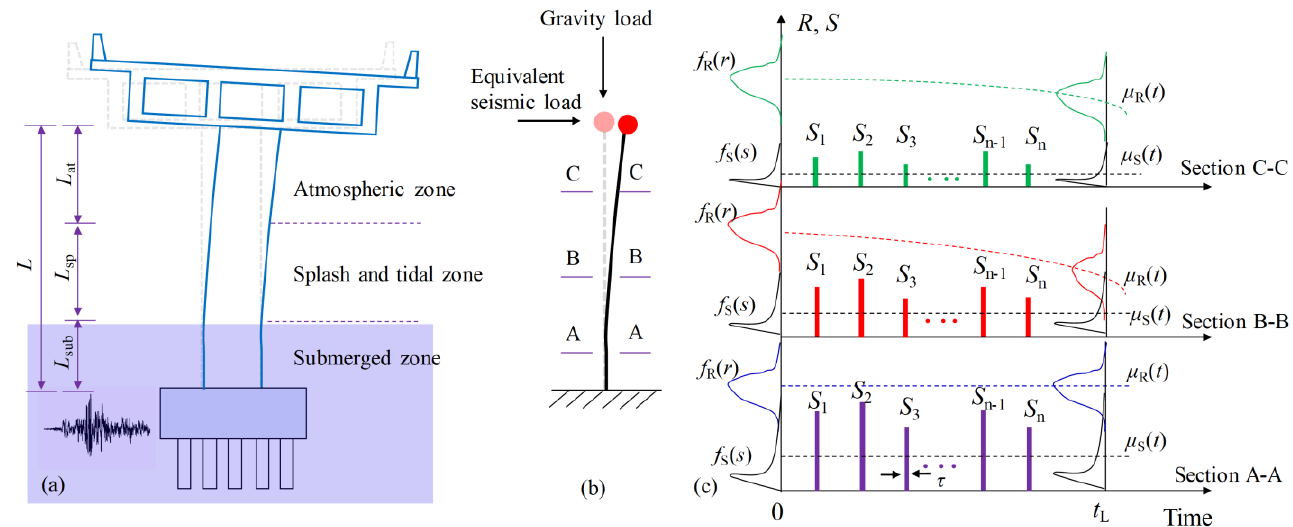
Figure 3. Schematic of seismic load action and the time-dependent resistance for a pier. ( a ) non- uniform corroded pier ( b ) equivalent force model (c) seismic load demand and resistance. uniform corroded pier ( b ) equivalent force model (c) seismic load demand and